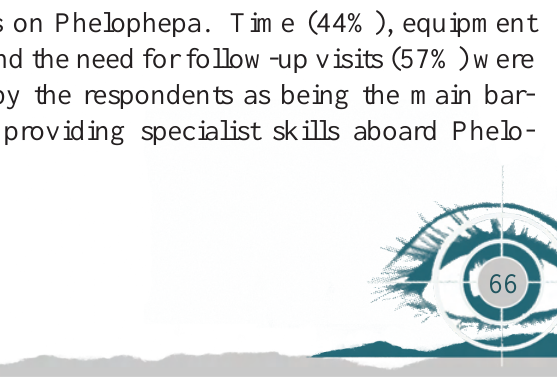
Figure 4: S pecialist skills required by